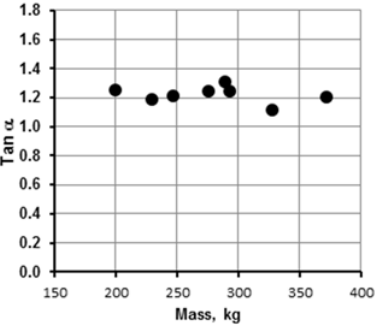
Figure 2. Plot of the slope as tan α verses stand-alone mass for work QBs in rear longitudinal instability.